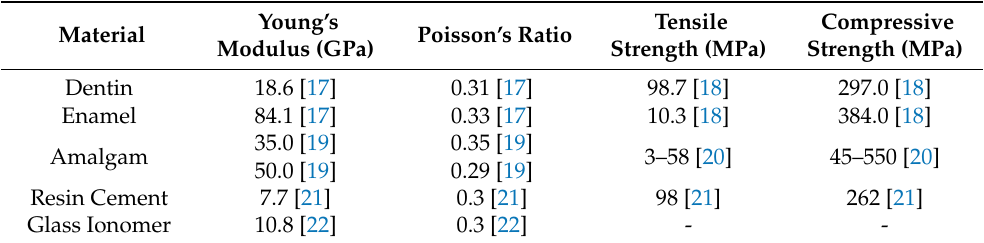
Table 1. Mechanical properties of tissues and materials used in 3D finite element stress analysis models of maxillary